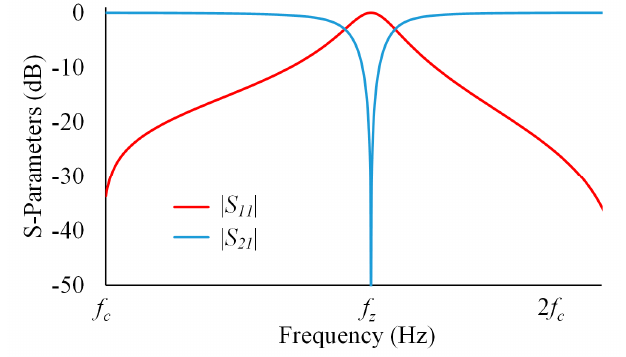
Figure 4. Simulated S-parameters results for a generic simplified multi-aperture iris.